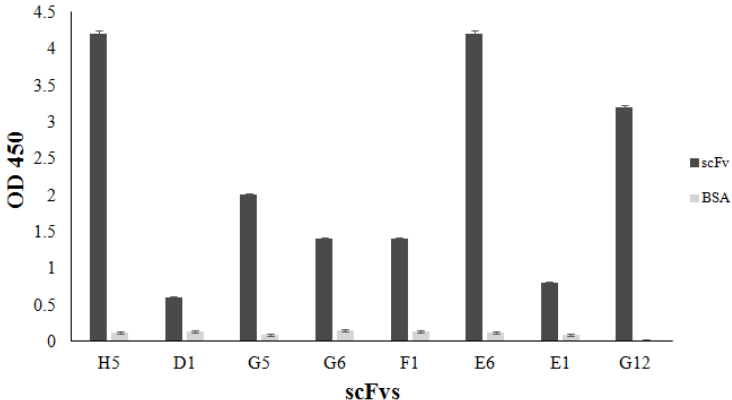
Figure 3. Binding activity for adiponectin of the expressed scFvs. The expressed scFvs were extracted